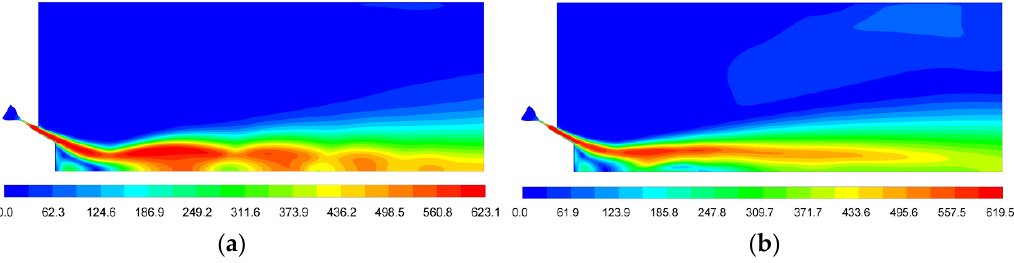
Figure 7. Velocity contour plots of the gas field in the region near the nozzle exit; ( a ) without particles, ( b ) with particles.